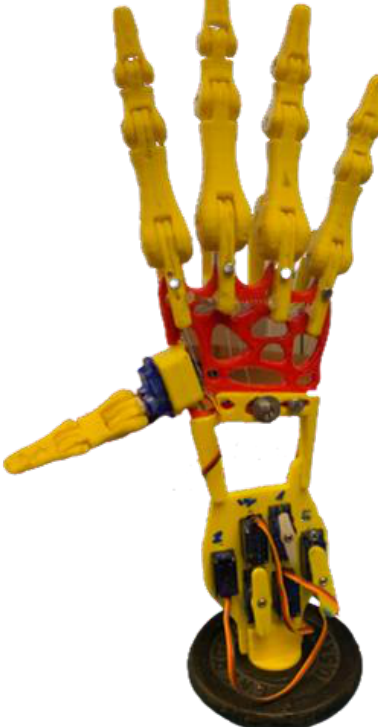
Figure 5. Full assembly of a bionic